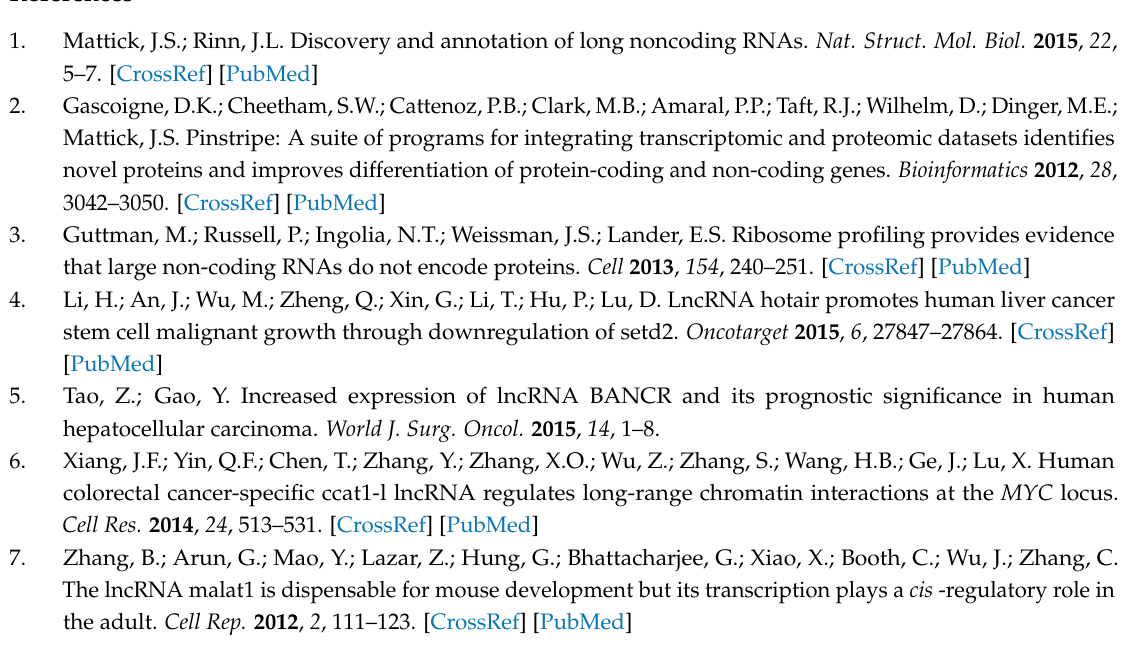
Figure S5 KEGG analysis of target genes in the 100 kb closest to lncRNA transcripts; Table S1 Statistics of clean stages; Table S6 Differentially expressed lncRNAs transcripts in different stages; Table S7 Length of 2002 lncRNA transcripts; Table S8 Total target genes in the 10 kb closest to 2002 lncRNA transcripts; Table S9 Total target genes transcripts common to all stages; Table S11 Primers